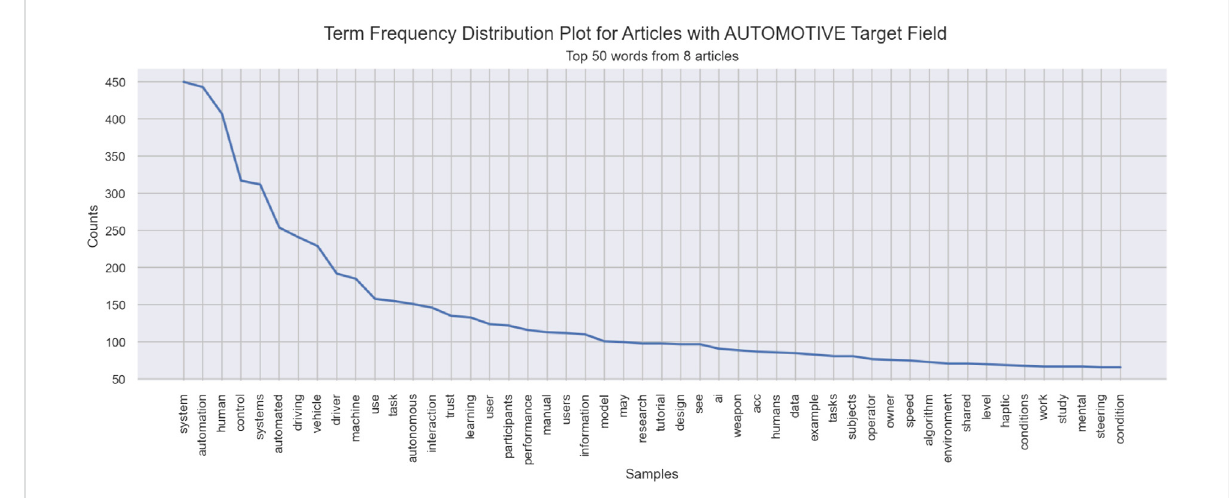
FIGURE 3 Term frequency